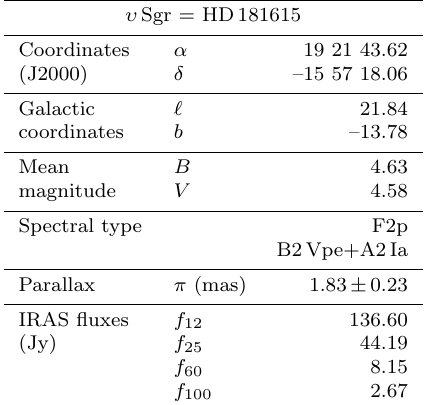
Table 1. Basic parameters of υ Sgr (SIMBAD